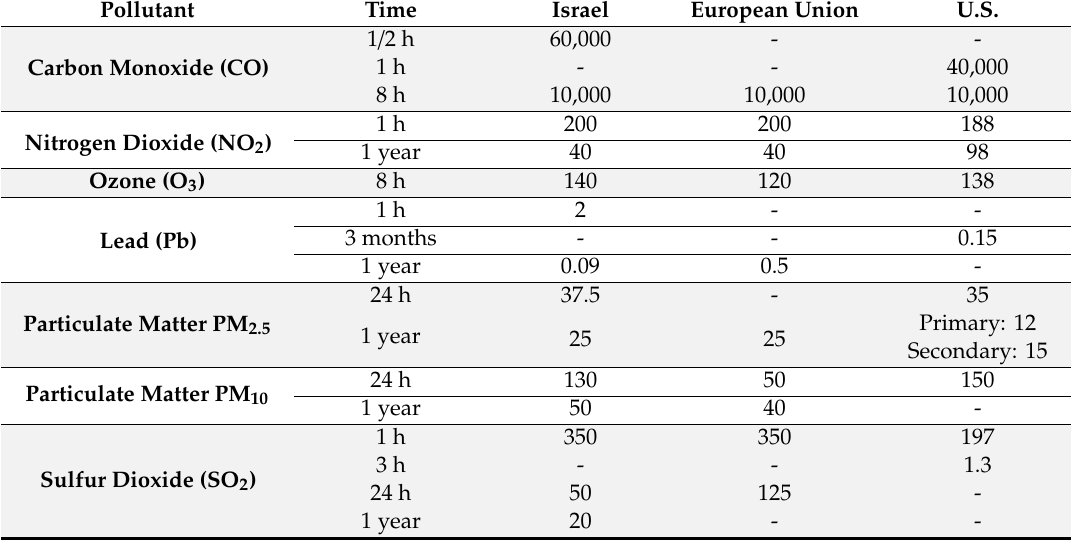
Table 1. Comparison of standards for the six principal pollutants in Israel, the European Union and the U.S. All values are in µ g / m 3